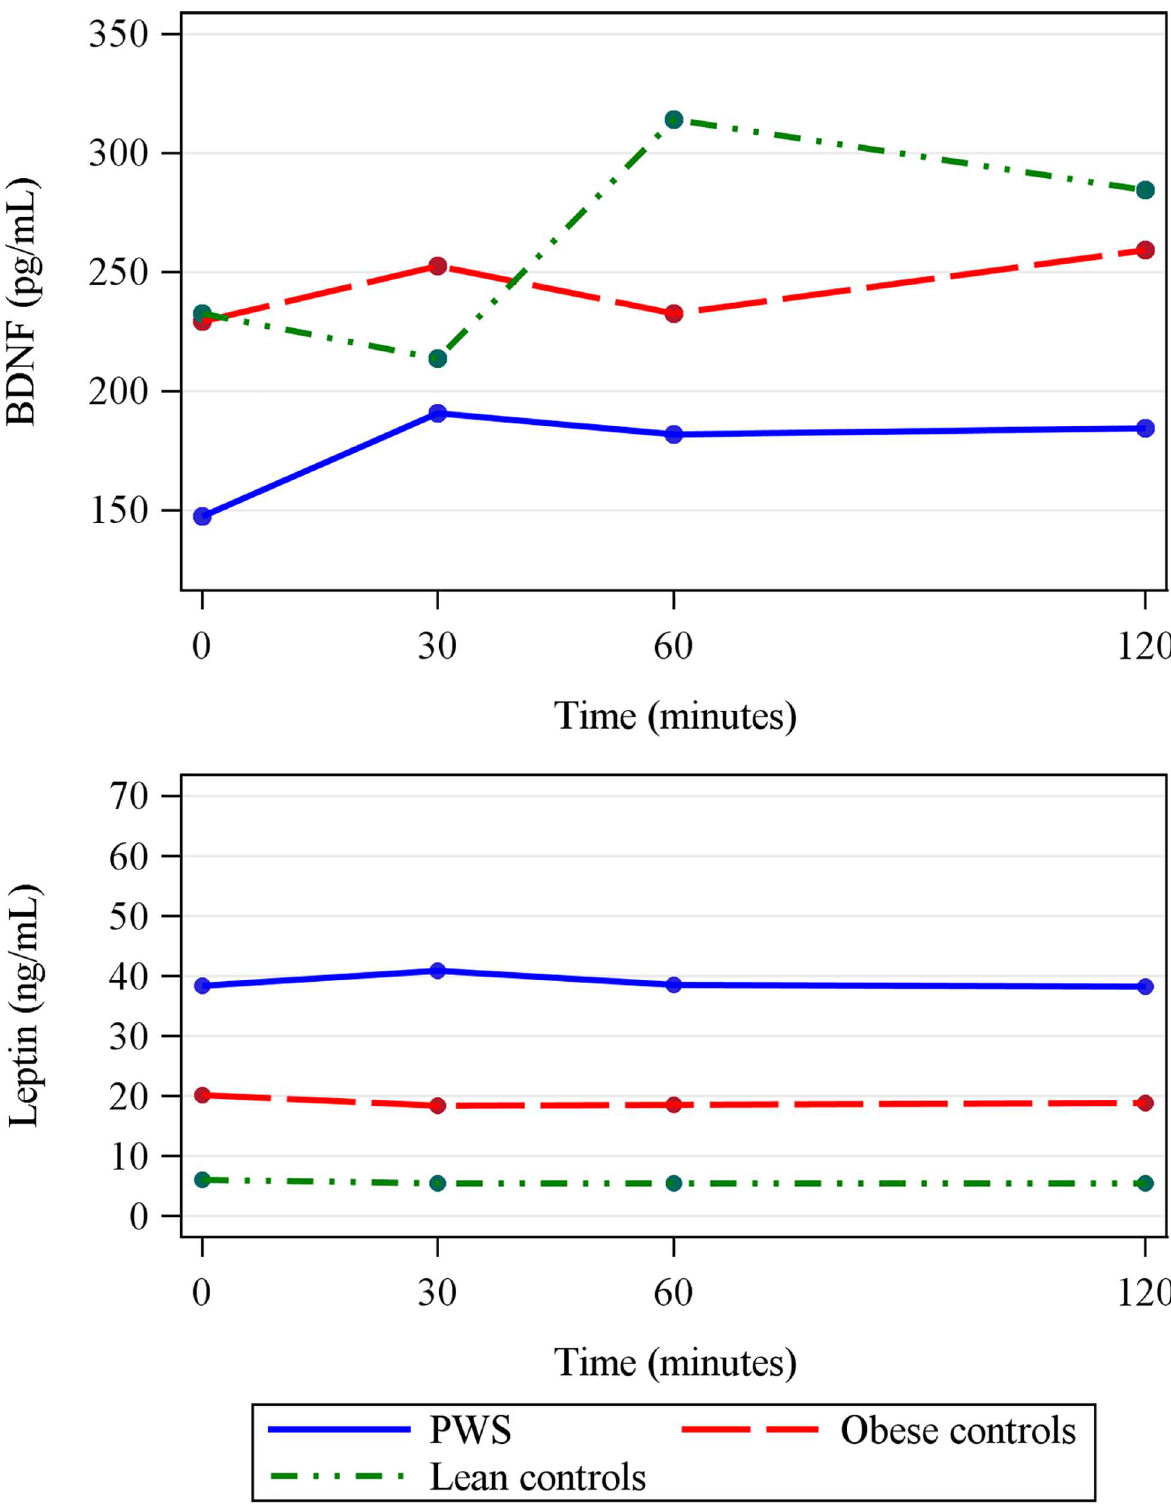
Fig 3. Postprandial BDNF (Brain-derived neurotrophic factor) (A) and leptin (B) levels in subjects with Prader-Willi syndrome (PWS), in obese controls, and in lean controls. A peak in BDNF at 60 min was observed only in lean subjects (p < 0.05 baselinevs 60 min in lean controls). Subjects with PWS had lower BDNF levels at 60 and 120 min than lean controls (p < 0.05). Leptin levels within groups did not change between baseline and postprandial measurements. PWS subjects had higher leptin levels than the other groups at all time points (p <